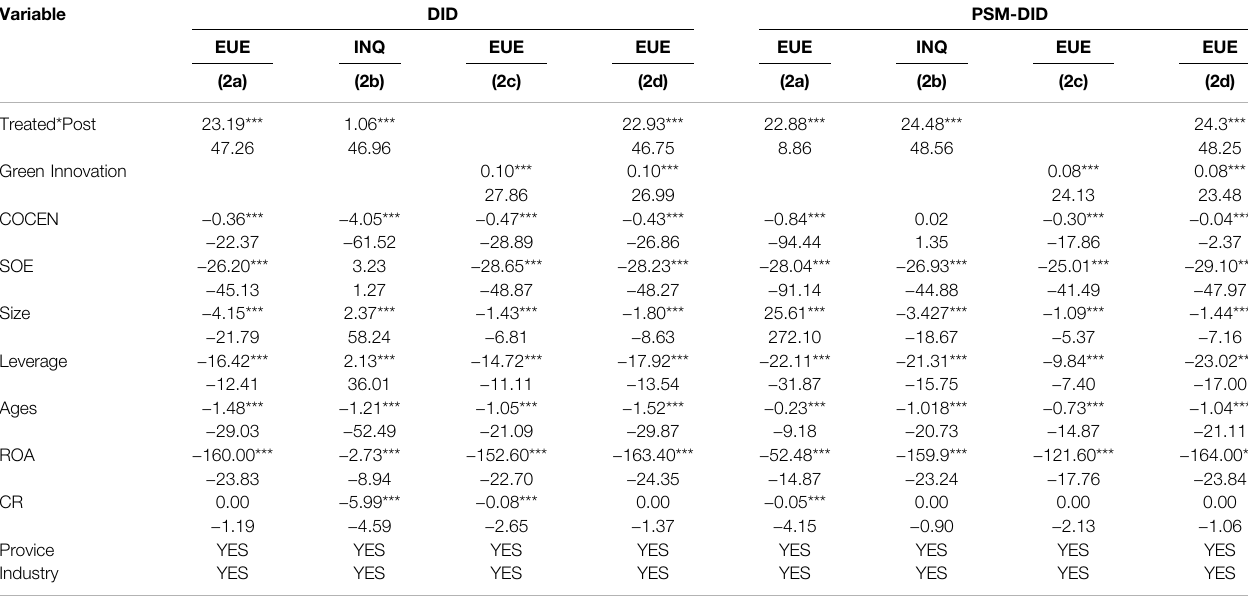
TABLE 12 | OLS robust standard error regression results about regulation. Variable